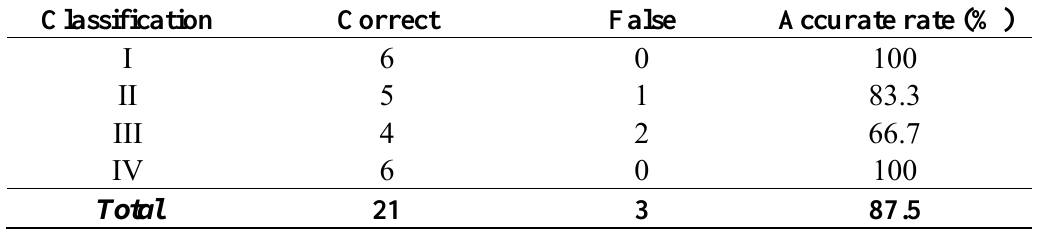
Table 2. The analysis results of hairtail fish in field measurement (Sample Number = 24).